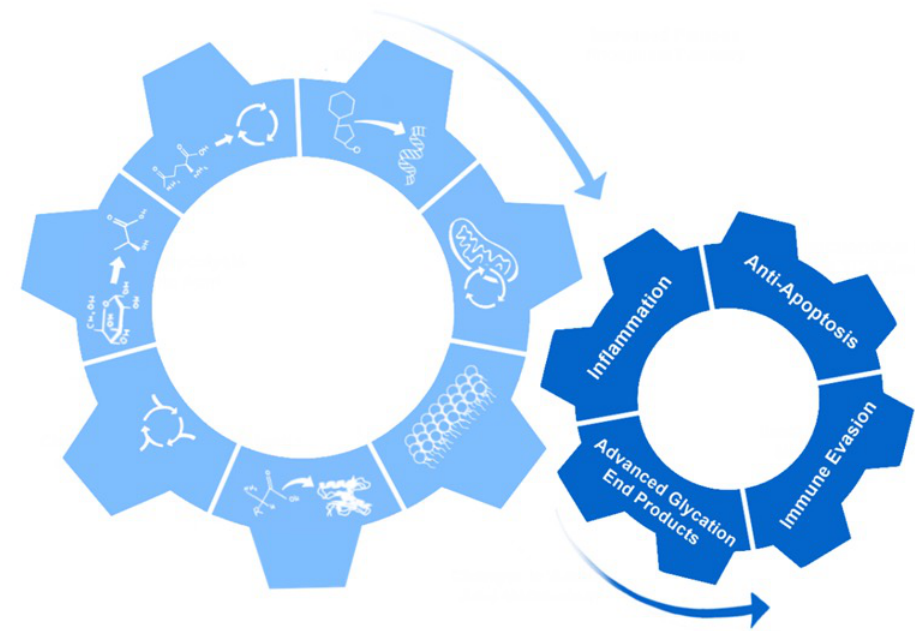
Figure 4. Non-metabolic effects of metabolic reprogramming. The cartoon shows how the seven hallmarks of metabolic reprogramming led to non-metabolic effects: inflammation, anti-apoptosis, immune evasion, and production of advanced glycation end